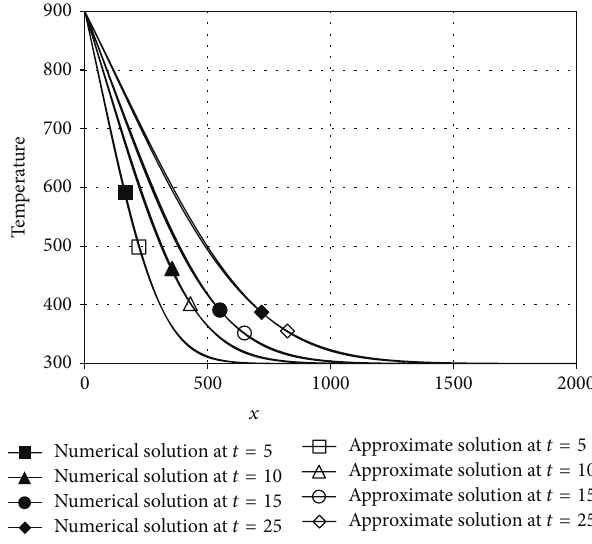
Approximate solution at t = 5 Numerical solution at t = 5 Approximate solution at t = 10 Numerical solution at t = 10 Approximate solution at t = 15 Numerical solution at t = 15 Approximate solution at t = 25 Numerical solution at t = 25 Figure 7: Comparison of approximate analytic solution 𝑇(𝑥,𝑡) and numerical solution of IBVP (8), (9) at different